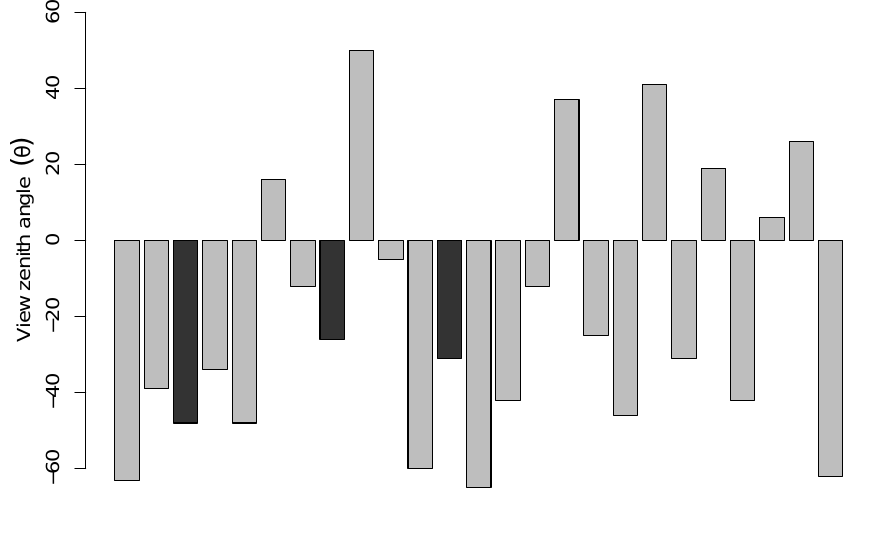
Figure 5. View zenith angles ( θ ) of the MODIS observations: negative values imply view from the east and positive angles are view from the west of Nadir (in total 25 observations in 14 days, dark-grey bars indicate